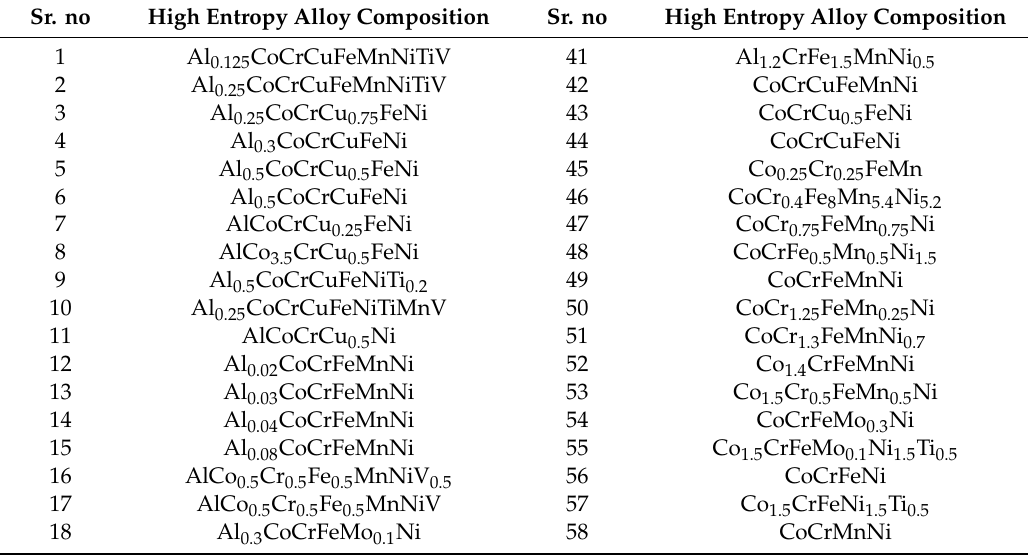
Figure A22. ( a – f ) X-Ray diffractograms of shortlisted HEAs. It can be seen that most of the alloys fabricated at relatively low temperature have more secondary phases and impurity peaks. We have observed both FCC and BCC lattices in these cases. Table A1. List of High Entropy Alloy Composition.